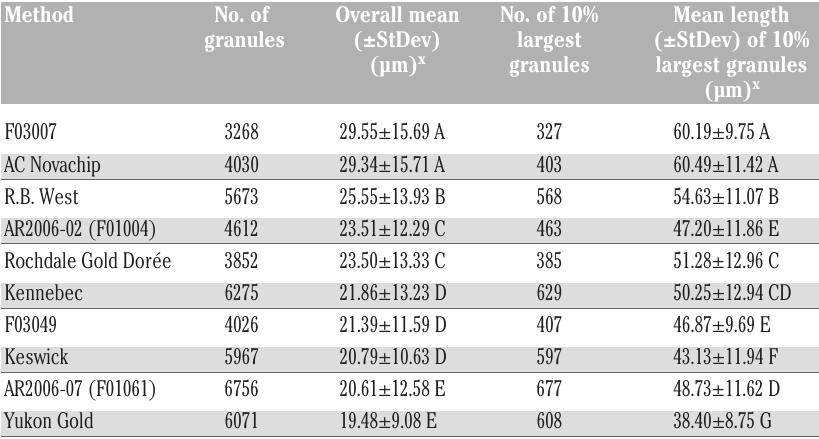
Table 2. ANOVA analysis of starch granule sizes and comparison between